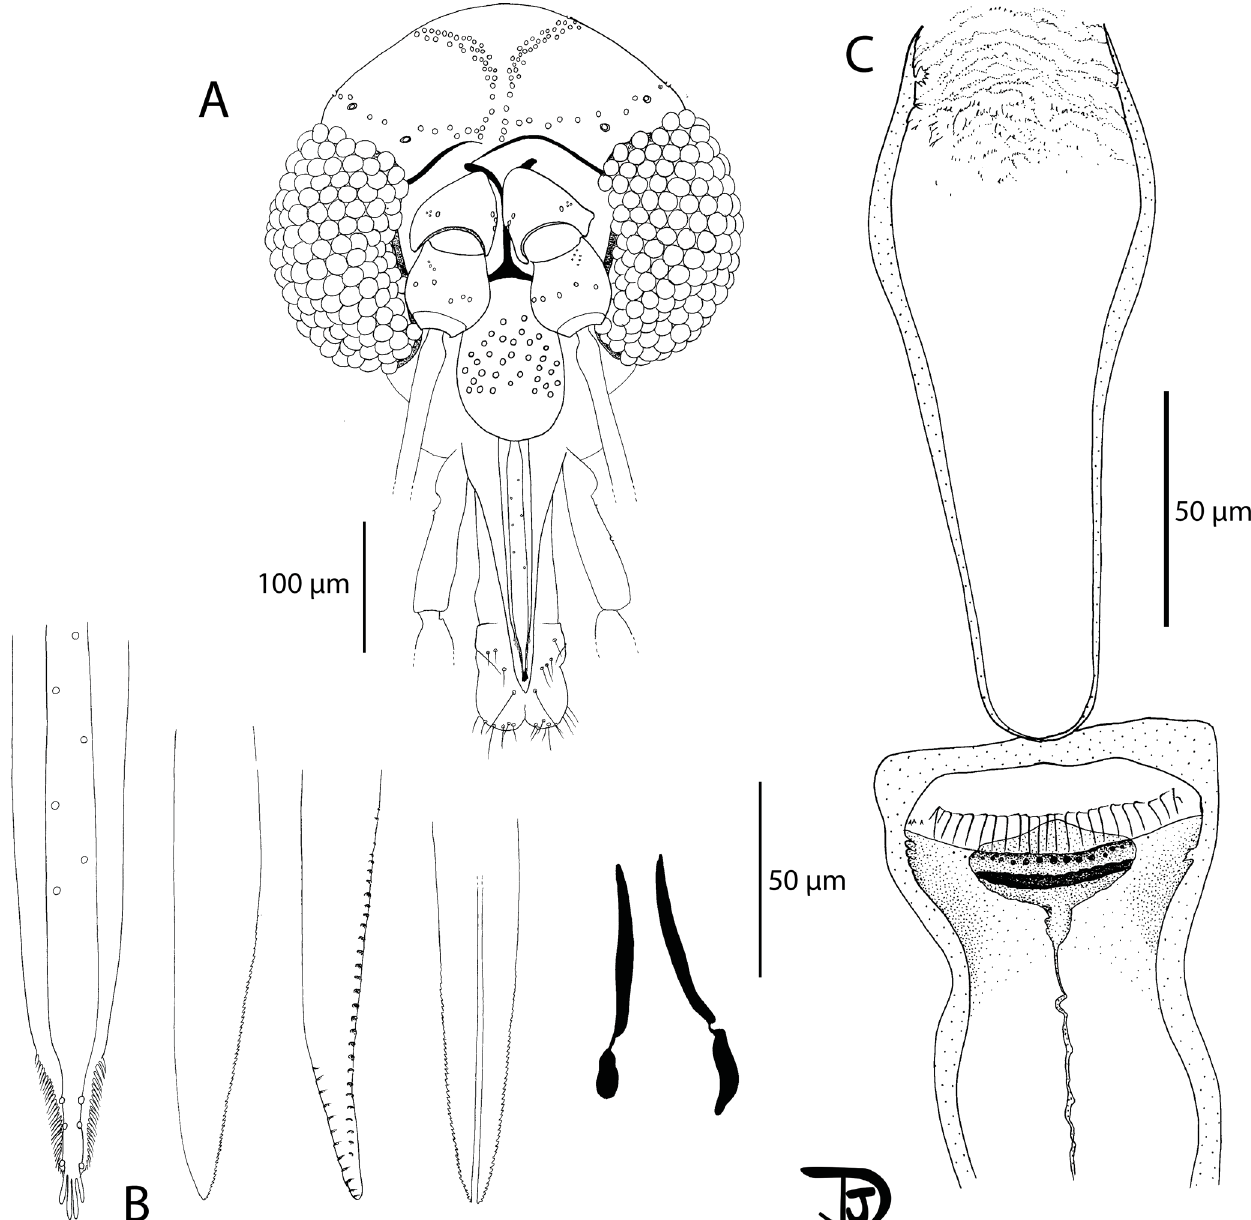
Figure 12. Sergentomyia (Rondanomyia) ozbeli n. sp. female (holotype MADA1001). (A) head, (B) mouth parts: labrum-epipharynx, mandible, maxilla, hypopharynx & labial furca, respectively, (C) pharynx and